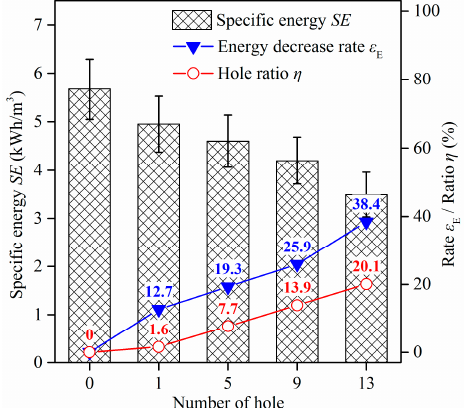
Figure 9. Effect of hole number on specific energy.